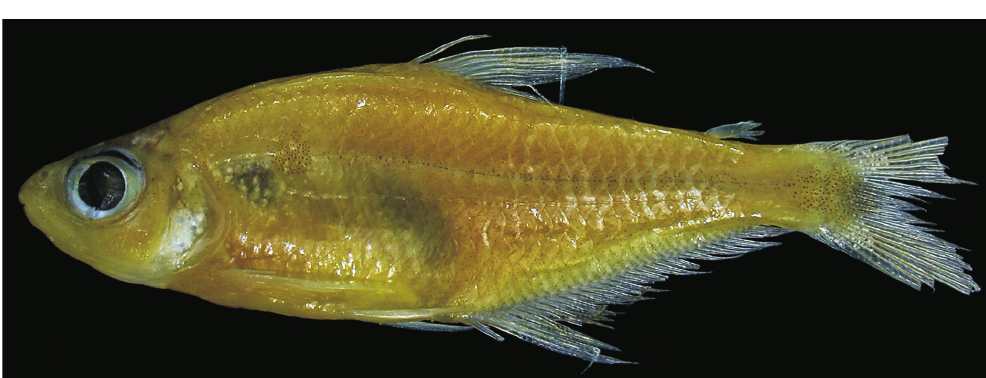
Figura 10. Phenacogaster retropinnus sp. nov. , INPA 31367, holótipo, 40,0 mm CP, Rio Aripuanã, sistema do Rio Madeira, Mato Grosso.